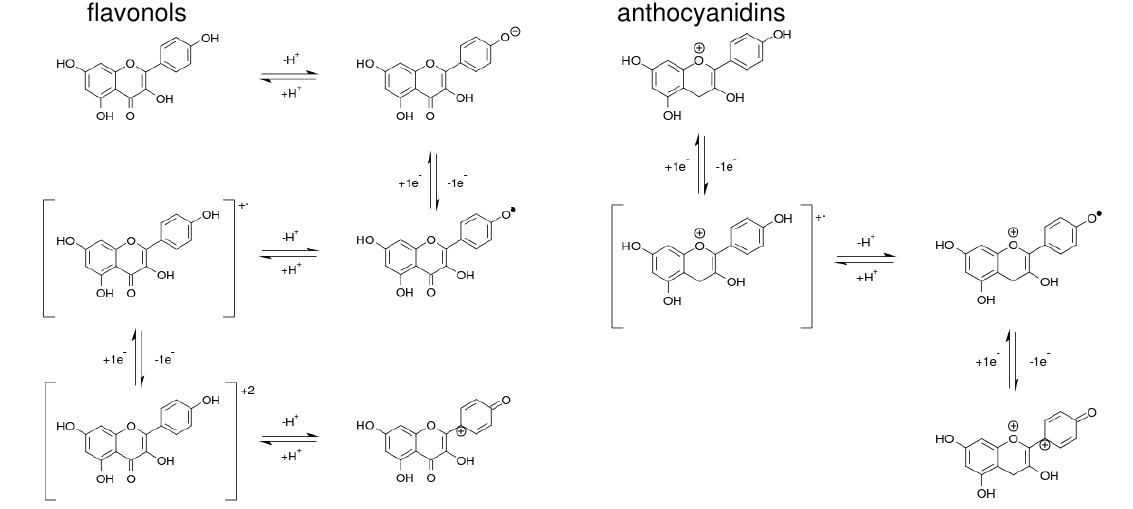
Figure 7. Proposed oxidation mechanisms for flavonols and